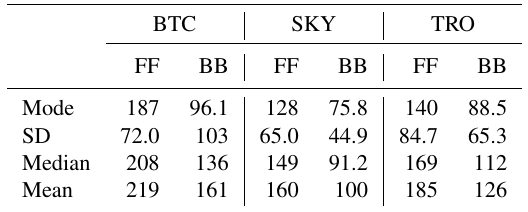
Table 3. Fitting parameters of the lognormal ER distributions (ngm − 3 ppm − 1 ) at the three locations of the city (see Fig. 5). The distributions are normalized to 1. The derived median and mean ER values are also shown.